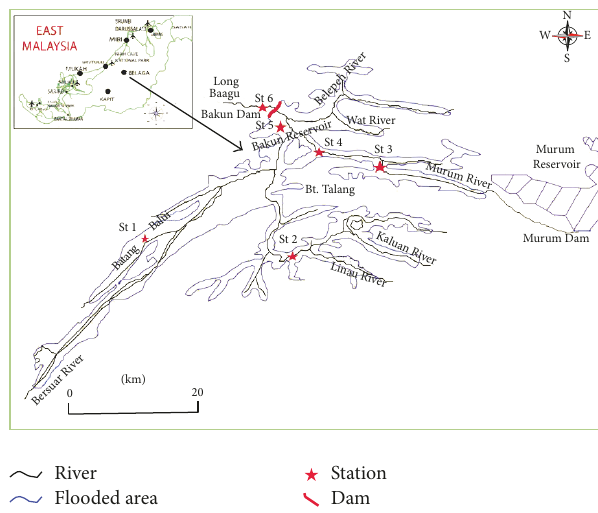
Figure 1: The study area and sampling stations in the present study.